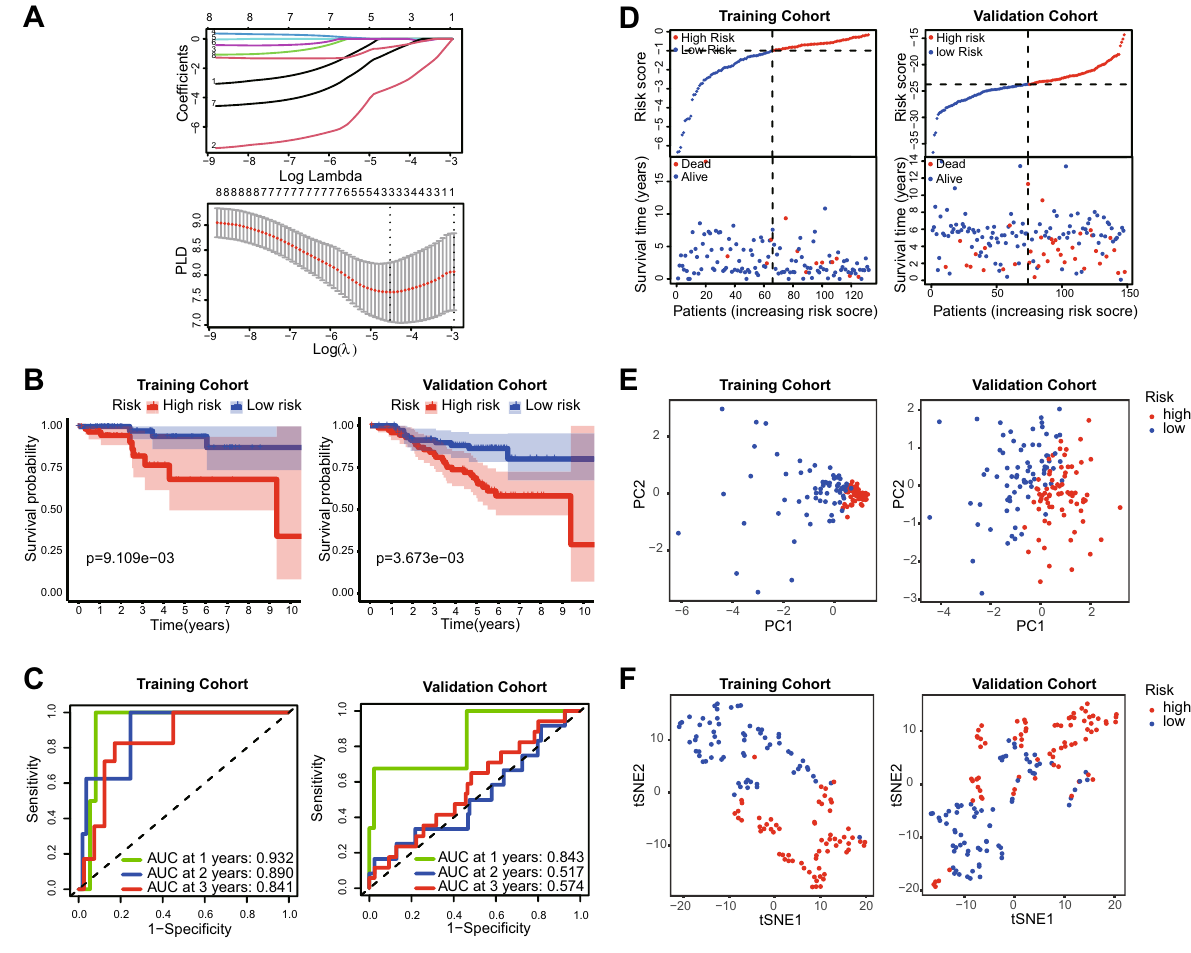
Figure 2. LASSO analysis based on survival-related genes and validation of the established risk model. ( A ) LASSO coefficient profiles (top) of survival-related genes and tenfold cross-validation results (bottom), which identified optimal values of the penalty parameter λ in the training cohort. ( B ) Kaplan–Meier survival curves of patients grouped by the risk score in the training cohort and validation cohort. ( C ) ROC curves of the risk model in training cohort and validation cohort. ( D ) HPBC patients were divided into high- and low-risk score groups according to the risk score model. ( E , F ) PCA and tSNE of the risk model in the training cohort and validation